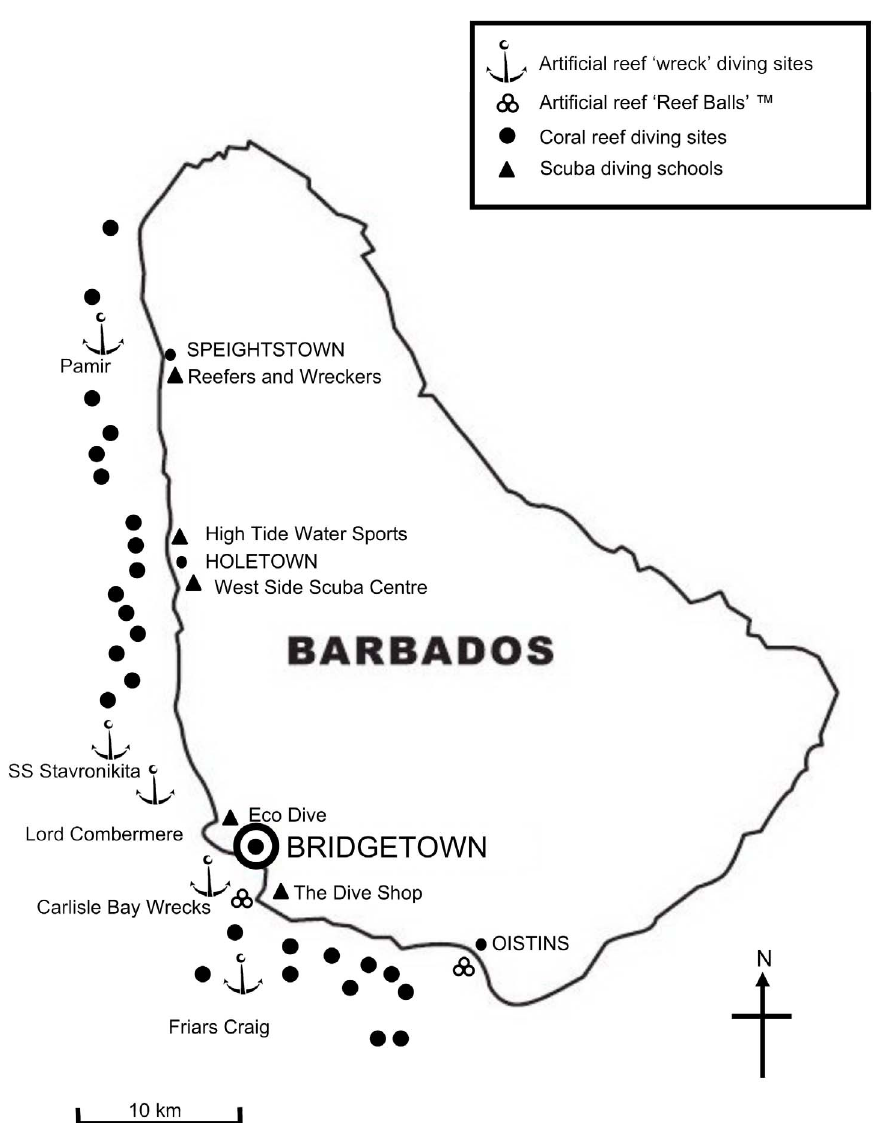
Figure 1. Map of Barbados. Locations of artificial reef and natural reef diving sites and diving schools.